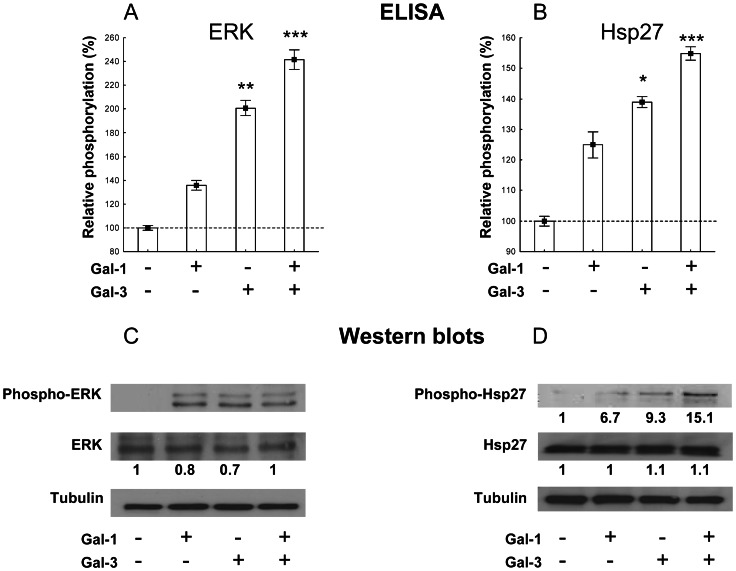
Galectin-induced activation of ERK1/2 and Hsp27.Determination of ERK1/2 (A, C) and Hsp27 (B, D) phosphorylation levels following a 10-min stimulation of EA.hy926 cells with galectin-1, galectin-3 or both galectins (1 µg/ml each), by ELISA (A, B) and Western blots (C, D). For ELISAs, the data (mean +/− SEM) are shown as relative values compared with the control (no galectin addition), and significant differences are indicated (* p<0.05, ** p<0.01 and *** p<0.001). Quantification of Western blots was done using ImageJ (see Materials and Methods).